Question: In a single sentence, describe what this figure presents.
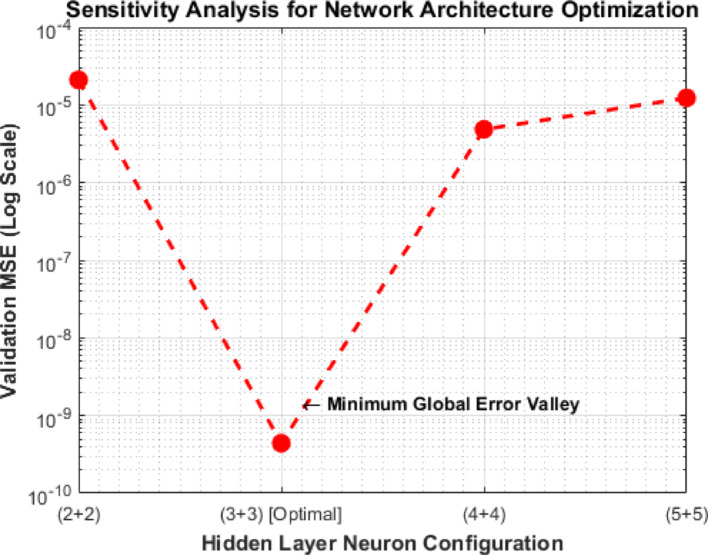
Answer: Sensitivity analysis curve demonstrating the validation MSE profiles across distinct hidden layer neuron configurations